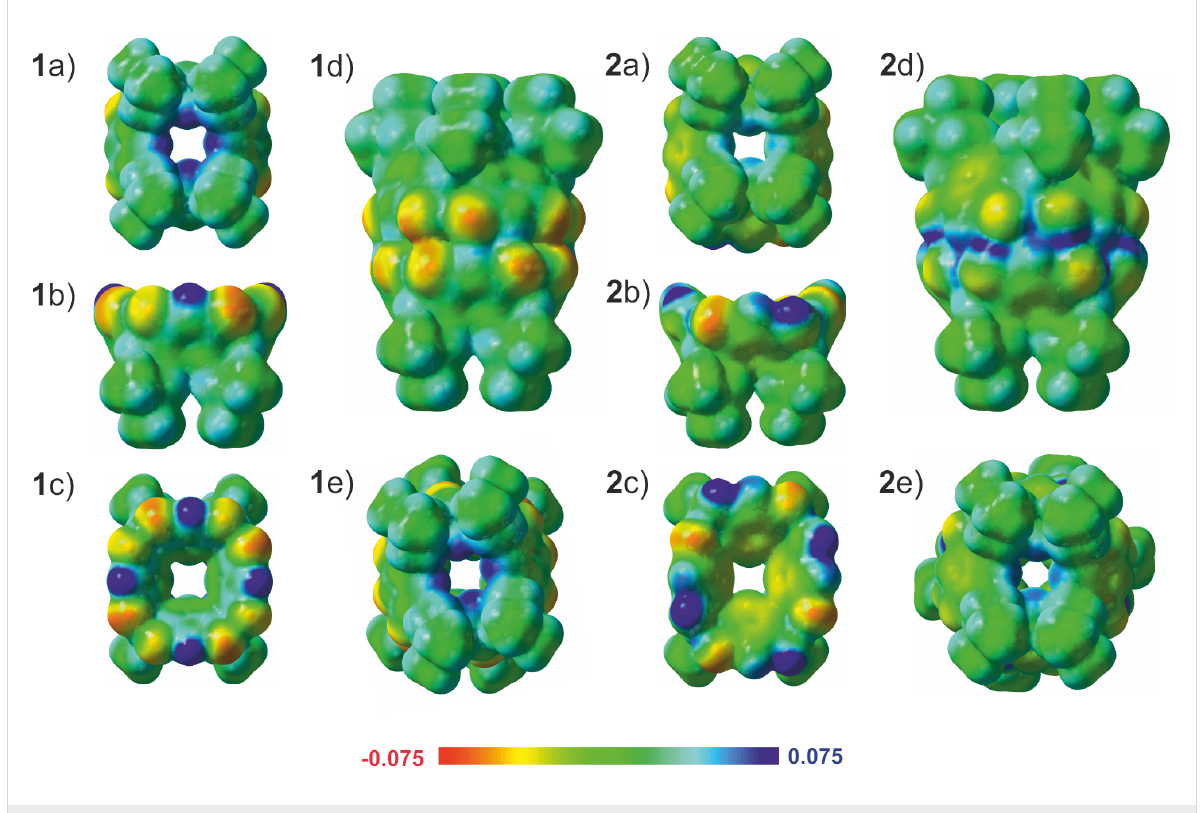
Figure 3: Calculated ESP surfaces (in au) superimposed on the total electron density (0.004 au) for 1 and 2 : a) monomer, bottom view b) monomer, side view c) monomer, top view, d) dimer, side view and e) dimer, bottom view. Red, blue and green surfaces indicate negative, positive and neutral ESP,